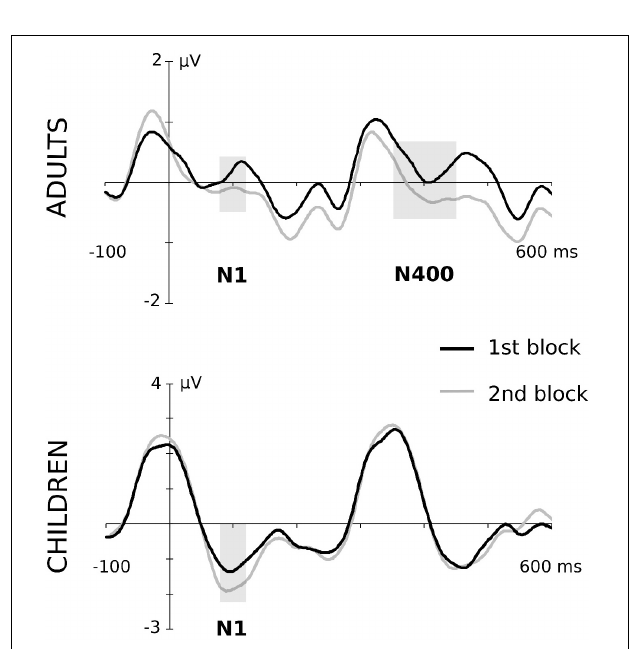
FIGURE 3 | Block effects in N100 and N400 components both in the adult and children groups. Grand-averaged waveforms correspond to central ROI in adults and fronto-central ROI in children. To assure the clarity of the graphical representation, the conditions of type of “word” and aSL task were collapsed. Gray-shaded rectangles indicate the time windows in which the block effect was significant. For a better visualization of the effects, data depicted in this figure were low-pass filtered at 25 Hz after grand